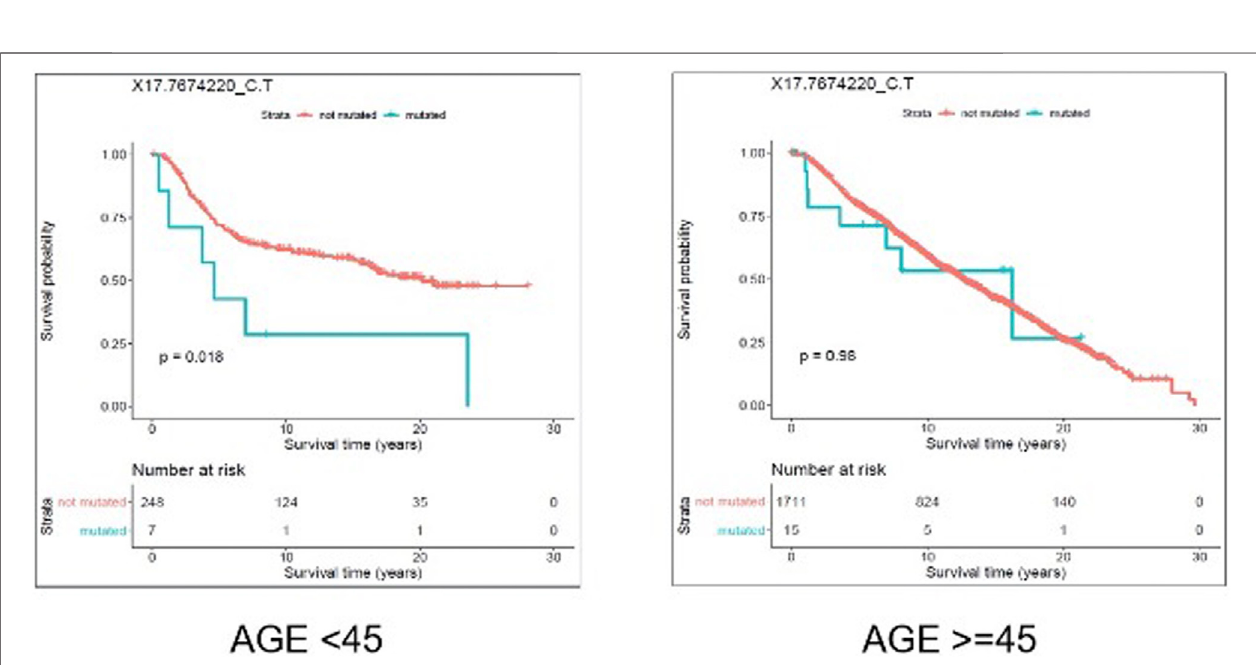
FIGURE 4 | Results from disease speci fi c survival (DSS) analysis comparing the survival time of breast cancer patients with and without the mutation X17.7674220_C.T. The difference between the two groups of patients (with and without the mutation) is signi fi cant among young (under 45 years of age) individuals ( p -value (cid:1) 0.037), but not signi fi cant in older patients ( p -value (cid:1) 0.88).